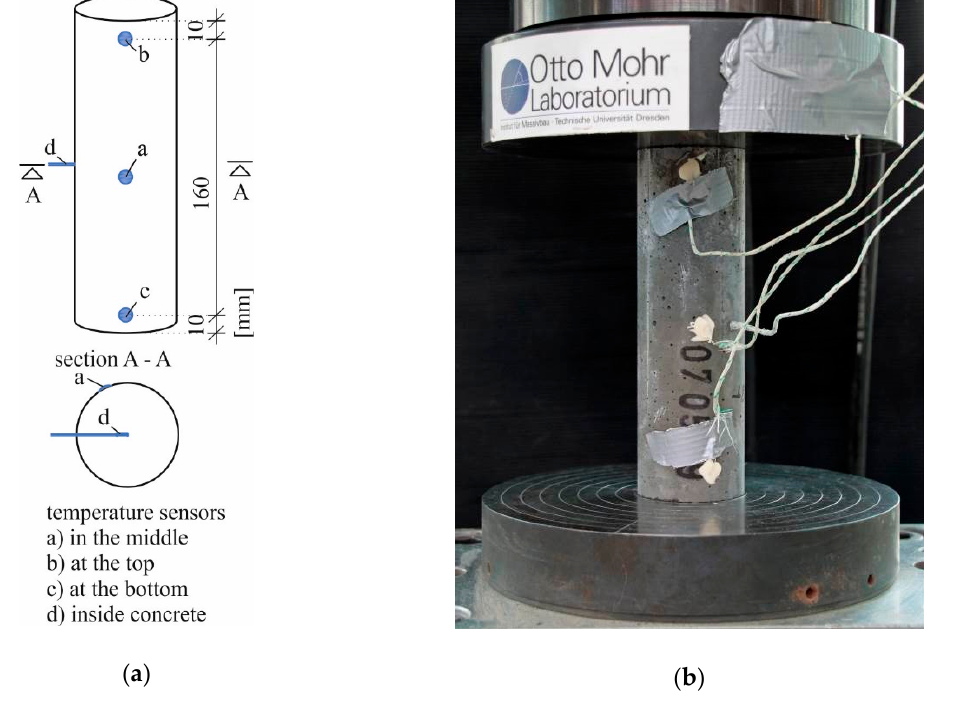
Figure 3. ( a ) Sensor positions for fatigue tests; ( b ) sample in the testing machine.